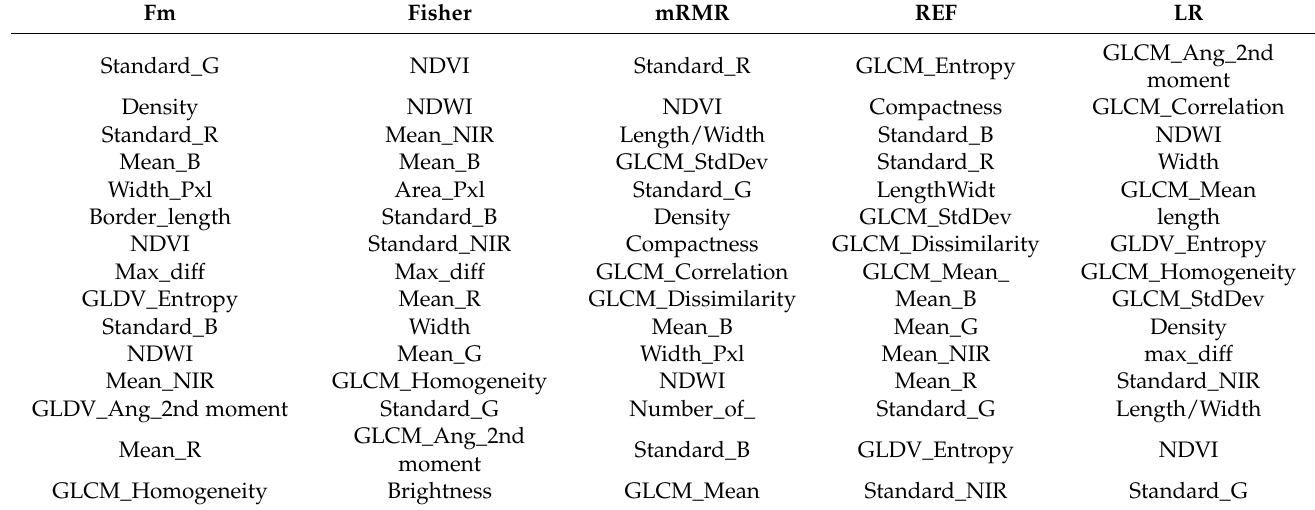
Table 2. Top 15 features using various FS methods.